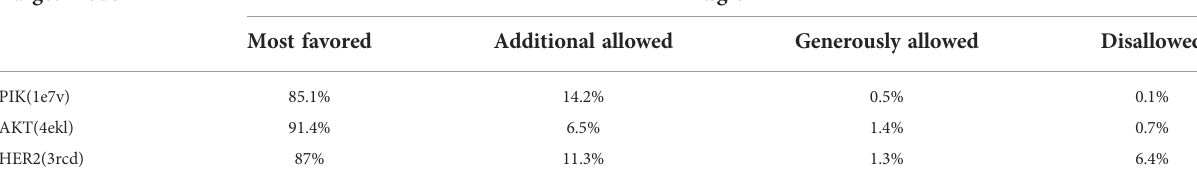
TABLE 1 Summary of results from Ramachandran plot of the models. Target